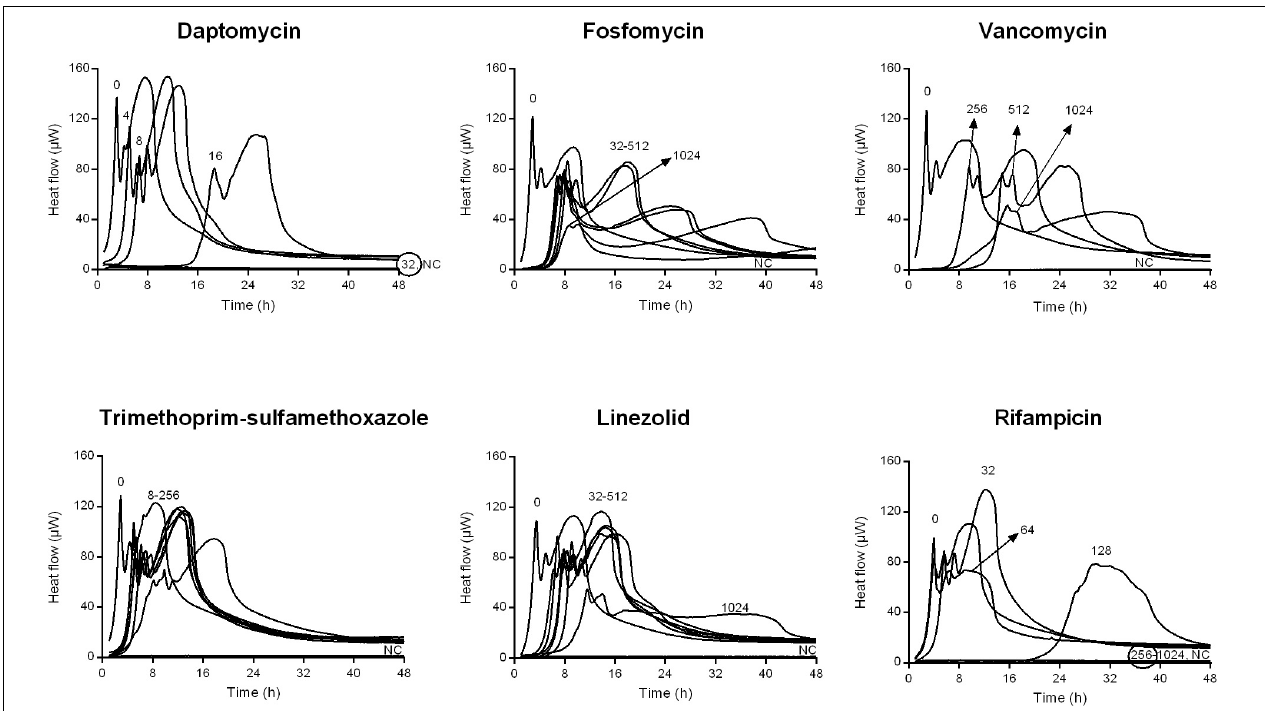
FIGURE 2 | Isothermal microcalorimetry evaluation of antimicrobial activity of daptomycin, fosfomycin, vancomycin, trimethoprim/sulfamethoxazole, linezolid, and rifampicin against biofilm MSSA. Numbers represent antibiotic concentrations ( µ g/ml). A negative control has been used to confirm medium sterility (NC). Trimethoprim/sulfamethoxazole concentrations are expressed as the trimethoprim concentrations. Circled values represent the MBBC. Representative data of replicated experiments are reported.